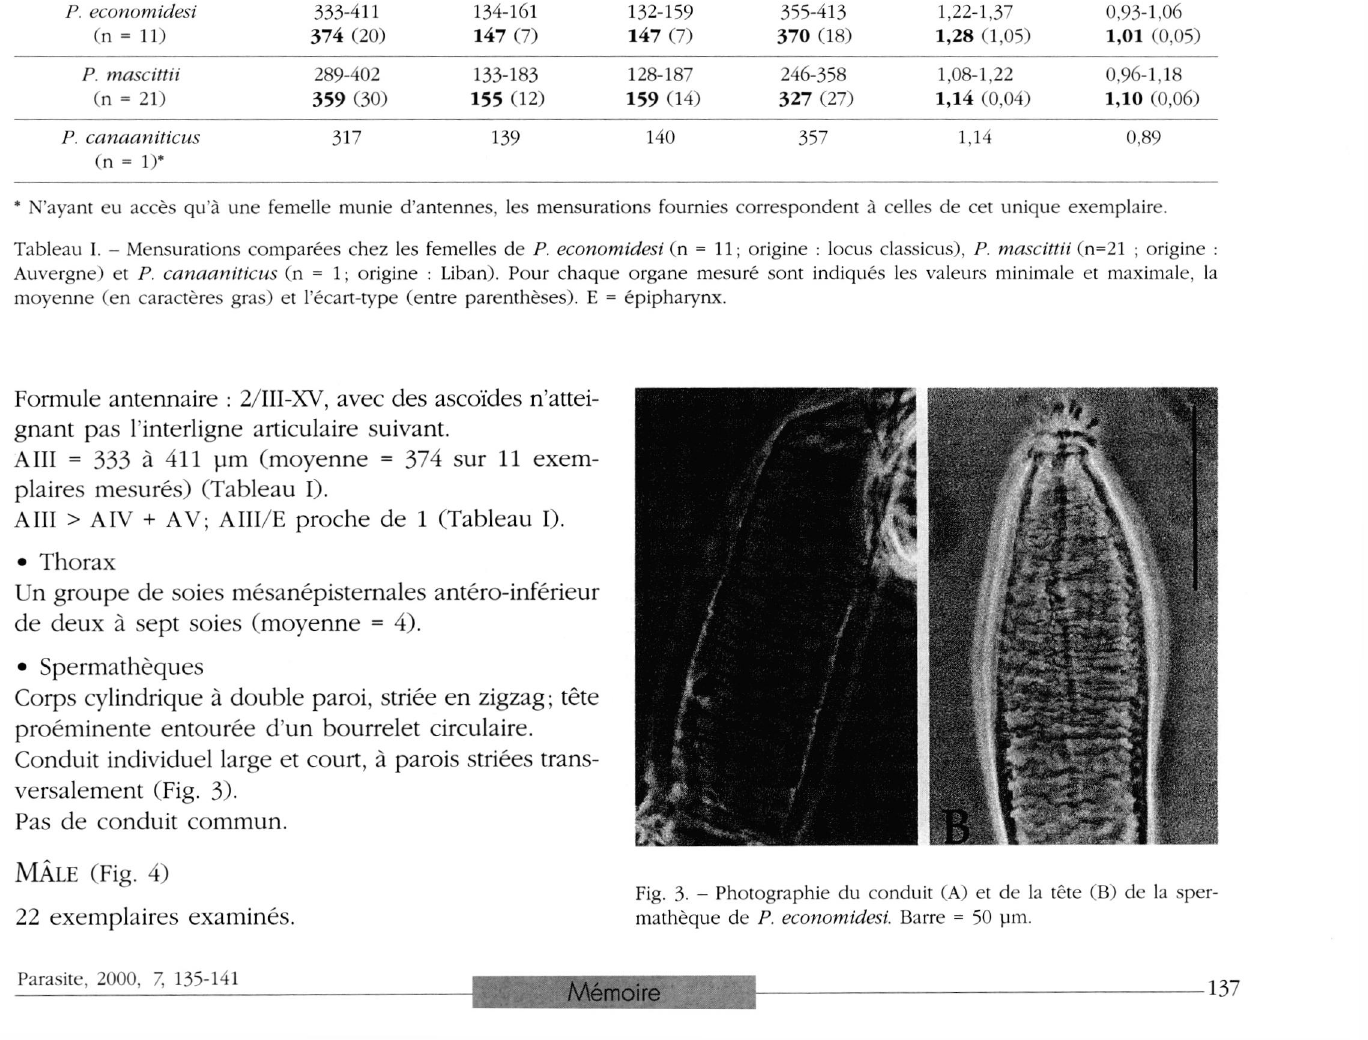
Fig. 3. - Photographie du conduit (A) et de la tête (B) de la sper- mathèque de P. economidesi. Barre = 50 pm.